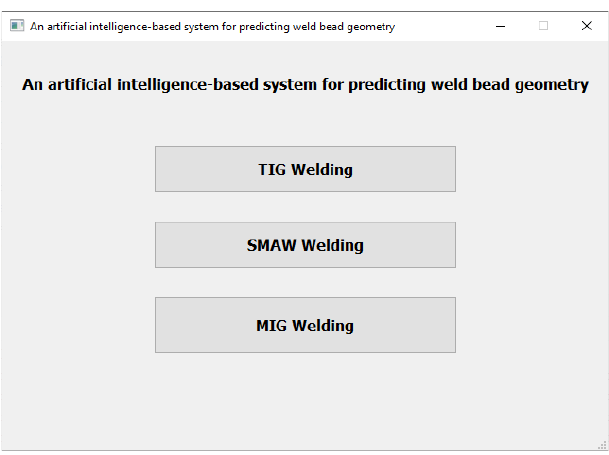
Figure 9. Screenshot of the interface module of the developed predictive system.